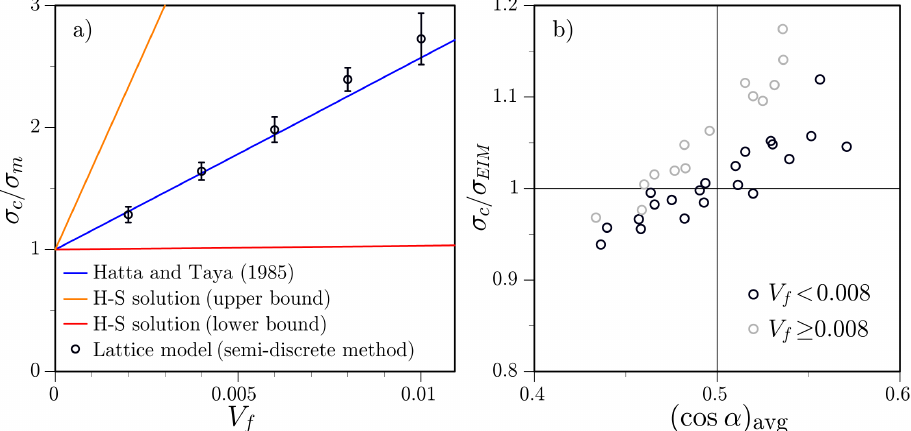
Figure 10. ( a ) Composite conductivity values based on semi-discrete fiber models. Seven nominally identical, randomly generated models were tested for each V f value; and ( b ) dependence of sim- ulated conductivity measurements on the orientation of fibers with respect to the direction of the electric